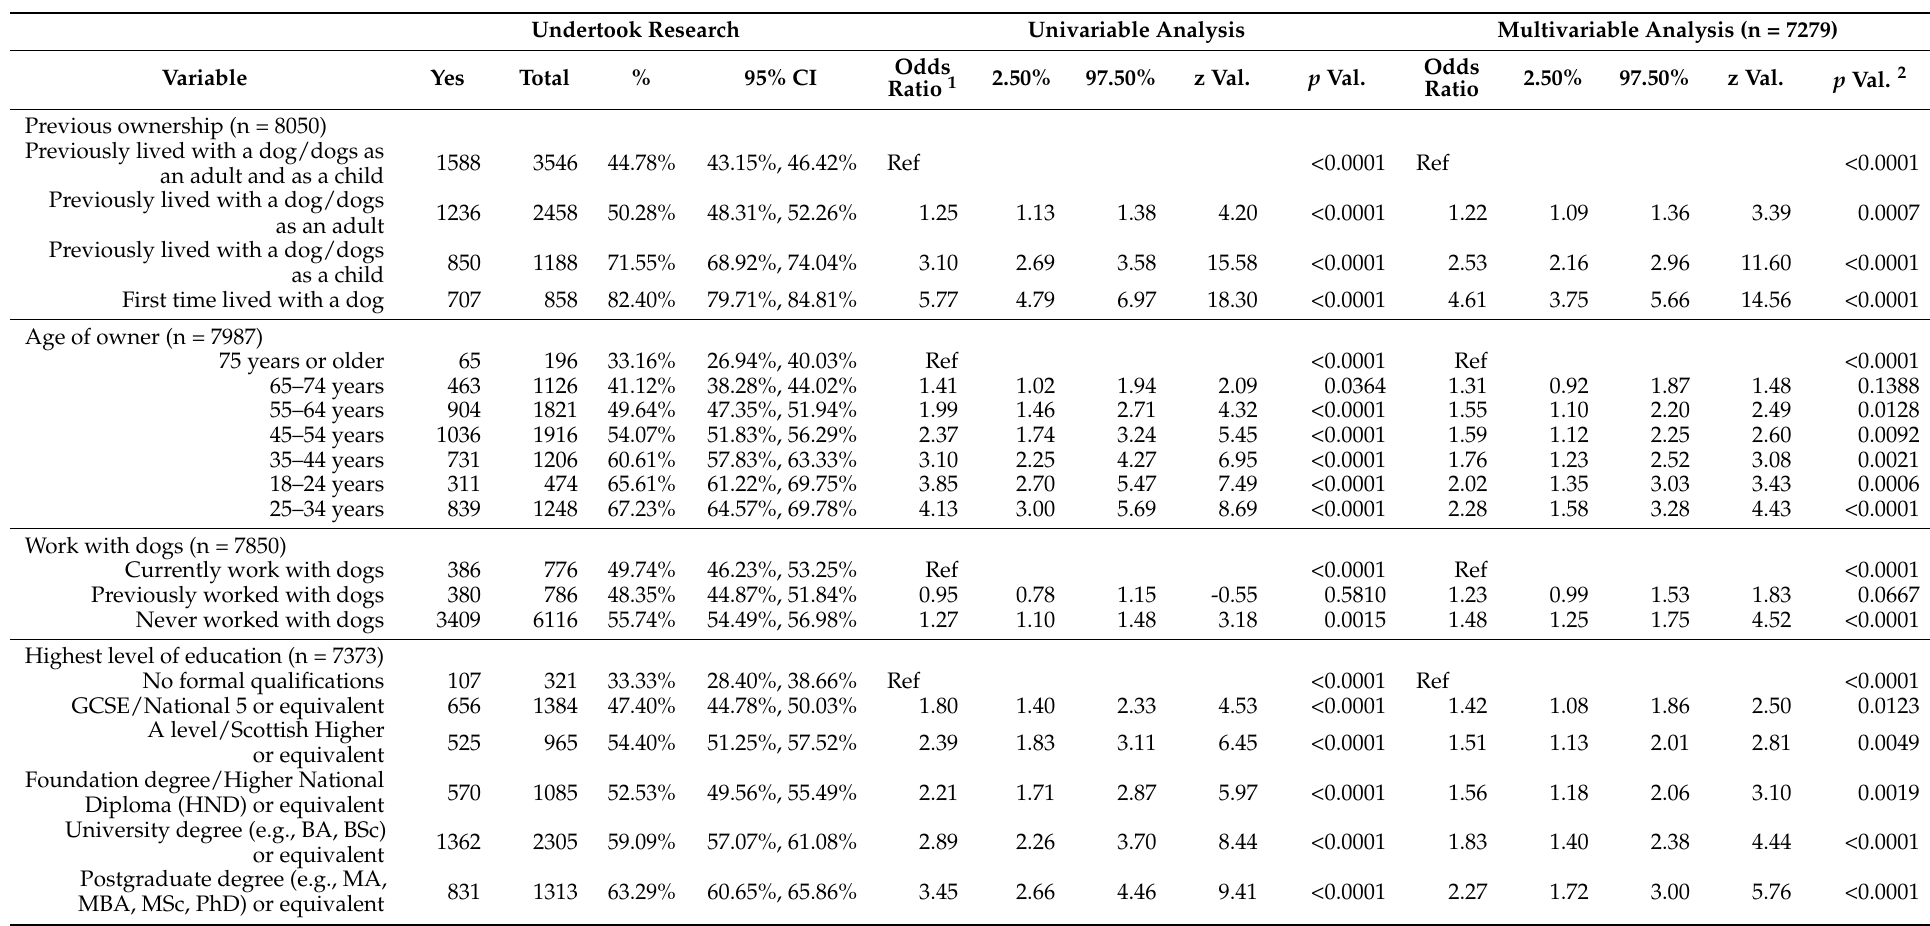
Table 1. Multivariable analysis of factors that affect whether research was undertaken prior to acquiring a dog for current owners (multivariable analysis n = 7279; univariable analyses n are given for each